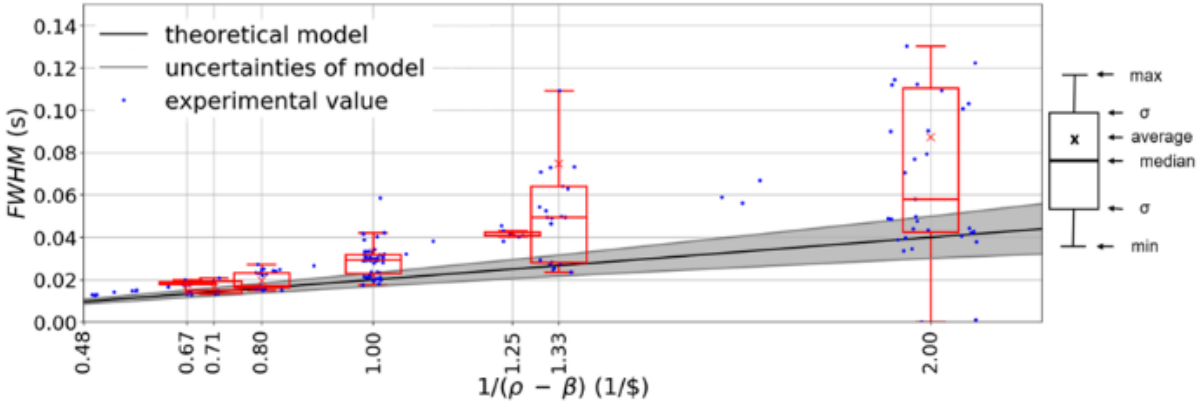
Figure 8: The comparison of the theoretical models with the experimental data for full width at half